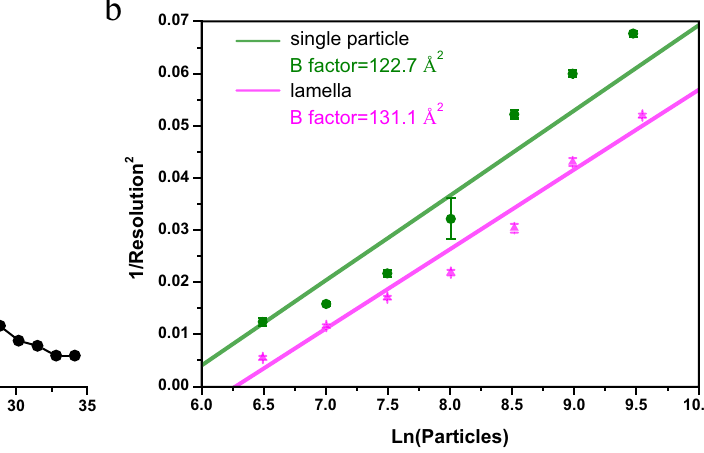
puri fi edPBS(green)andinsituPBS(magenta)of P.purpureum ,indicatingsimilarB factor estimations. The error bars in both plots represent the standard deviation from eightfoldrandom resampling.Source data are providedasa SourceData fi